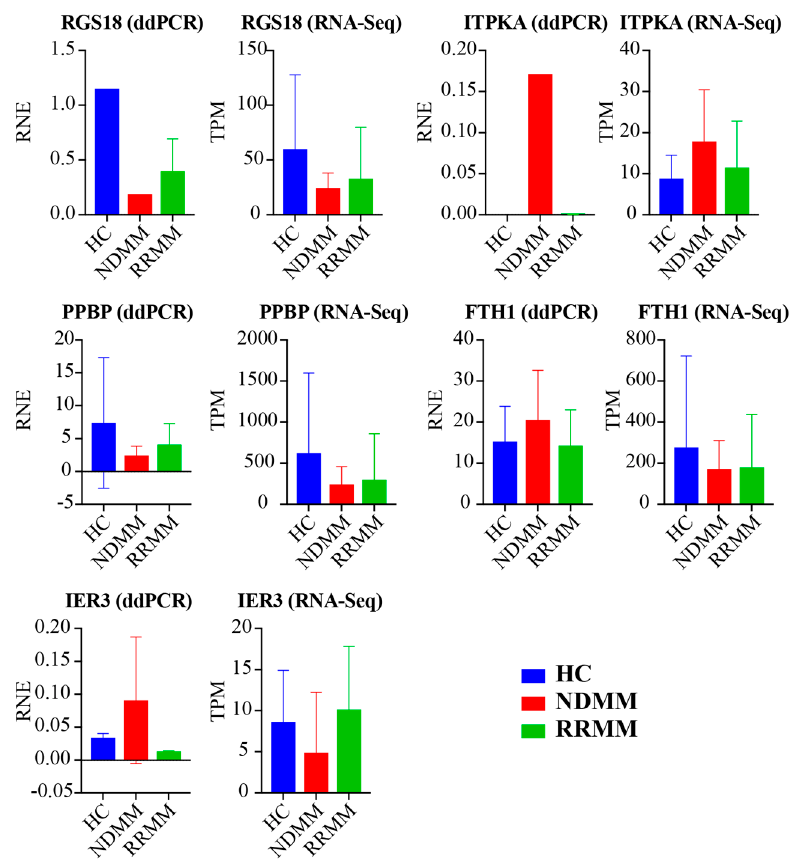
Figure 4. Digital Droplet PCR (ddPCR) validation. Five DGEs were selected and compared to RNA-Seq. Their expression was normalized to GAPDH and was present in relative normalized expression (RNE) by ddPCR. Their normalized expression identified by RNA-Seq was shown in transcripts per million reads (TPM).